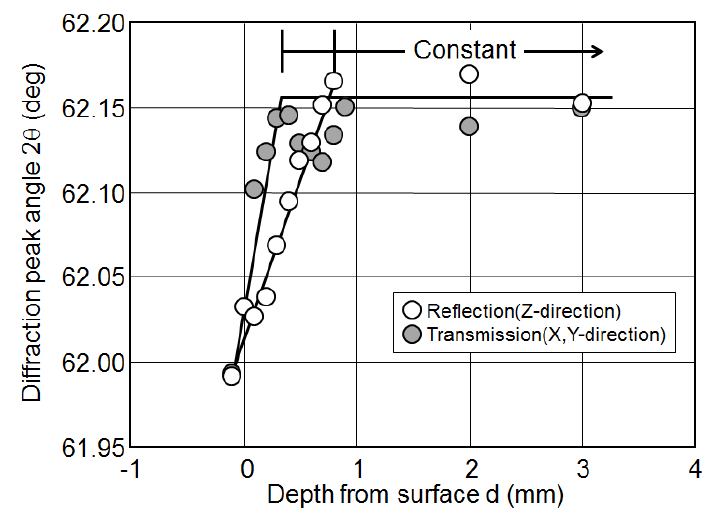
Figure 11. Pseudo peak shifts due to gauge volume deviating from measurement sample.